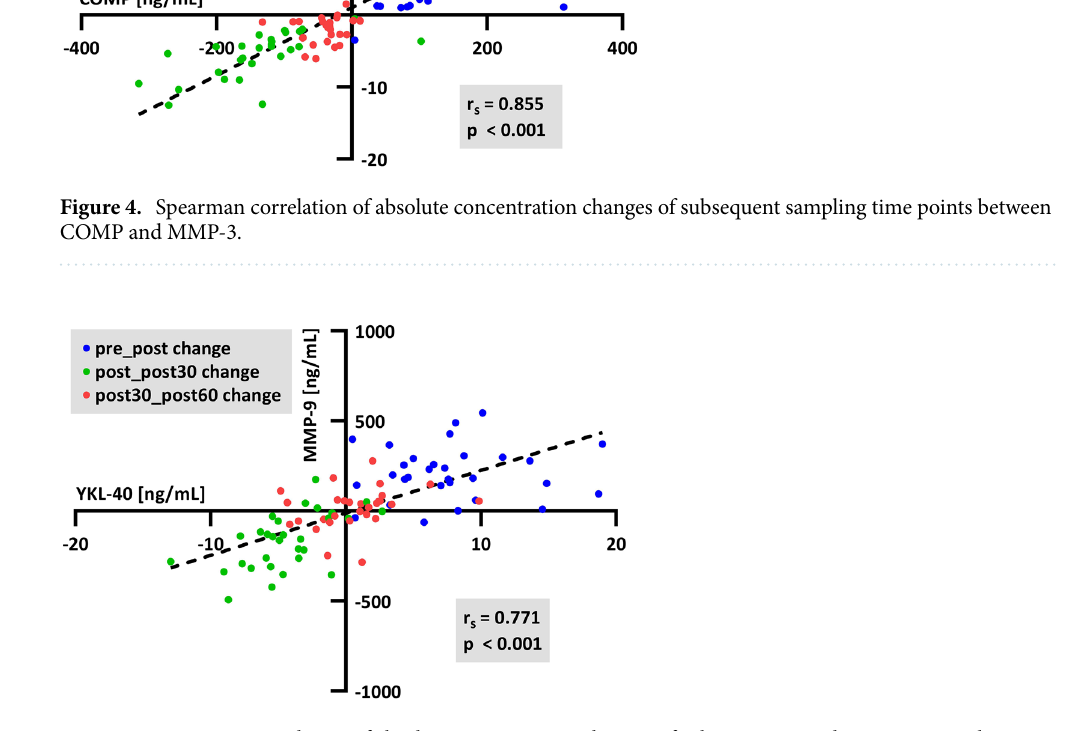
Figure 5. Spearman correlation of absolute concentration changes of subsequent sampling time points between YKL-40 and